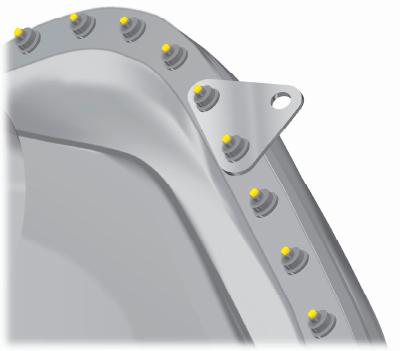
Appl. Sci. 2021 , 11 , x FOR PEER REVIEW Figure 6. Bracket A secured to the structure in the final assembly location. Figure 6. Bracket A secured to the structure in the final assembly location. Figure 6. Bracket A secured to the structure in the final assembly location.